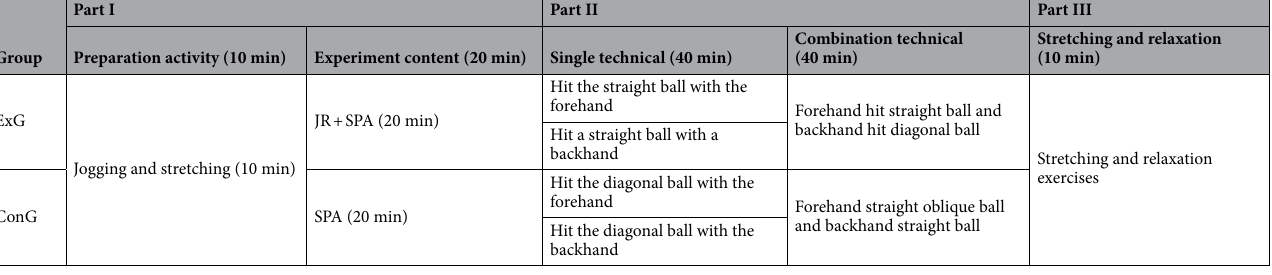
Table 2. Experiment content and schedule